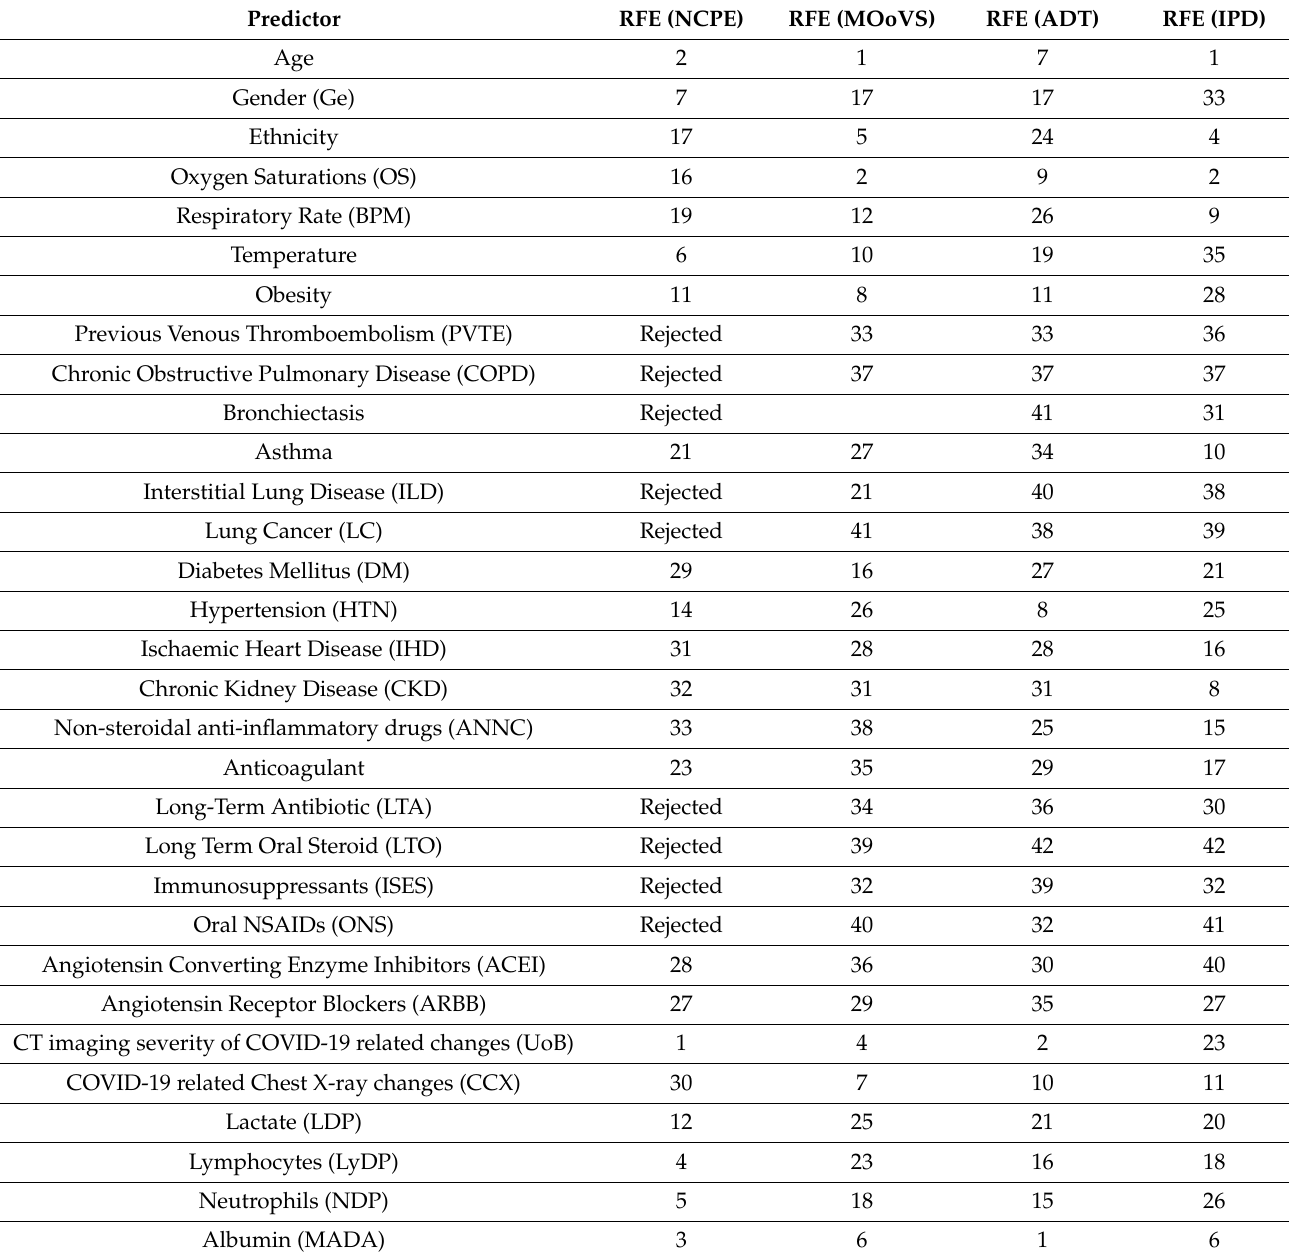
Table 2. Feature selection results for four different outcomes; IPD, ADT, NCPE and MOoVS.